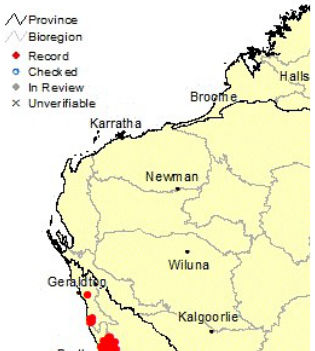
Figure 1. Government surveyed locations of Corymbia calophylla (Herbarium,